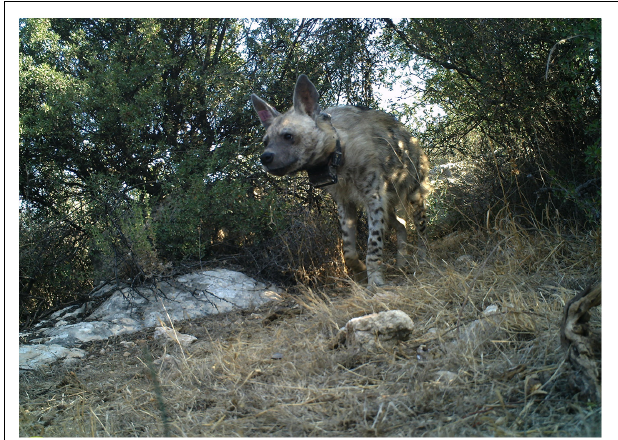
FIGURE 2 | An adult striped hyena female 6163A caught in a camera trap after being fitted with a GPS collar and an ear tag.